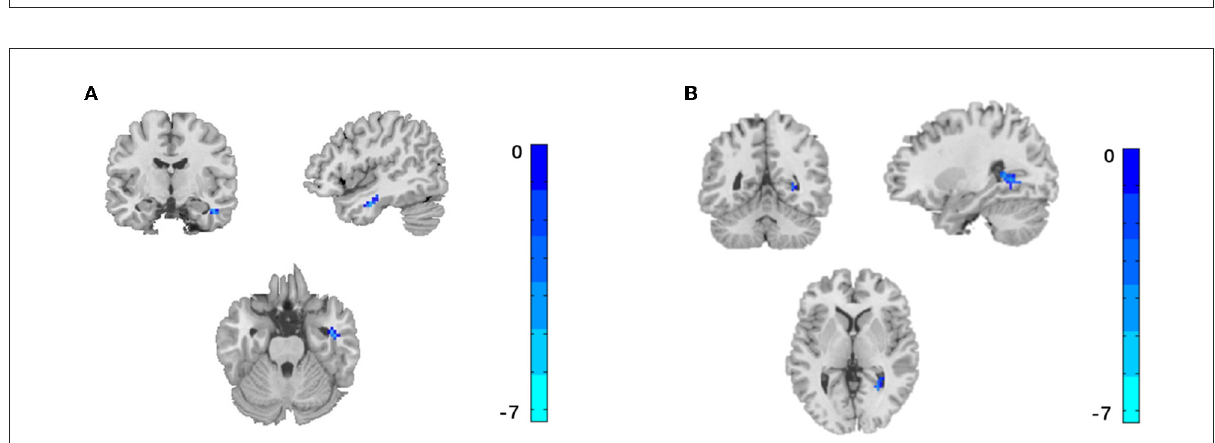
FIGURE3 Significant difference for FC between pre-acupuncture in subjective tinnitus and healthy control. The result was corrected for GRF with voxel p < 0.001, cluster p < 0.05. (A) FC between AMYG and right inferior temporal gyrus. (B) FC between AMYG and right precuneus.